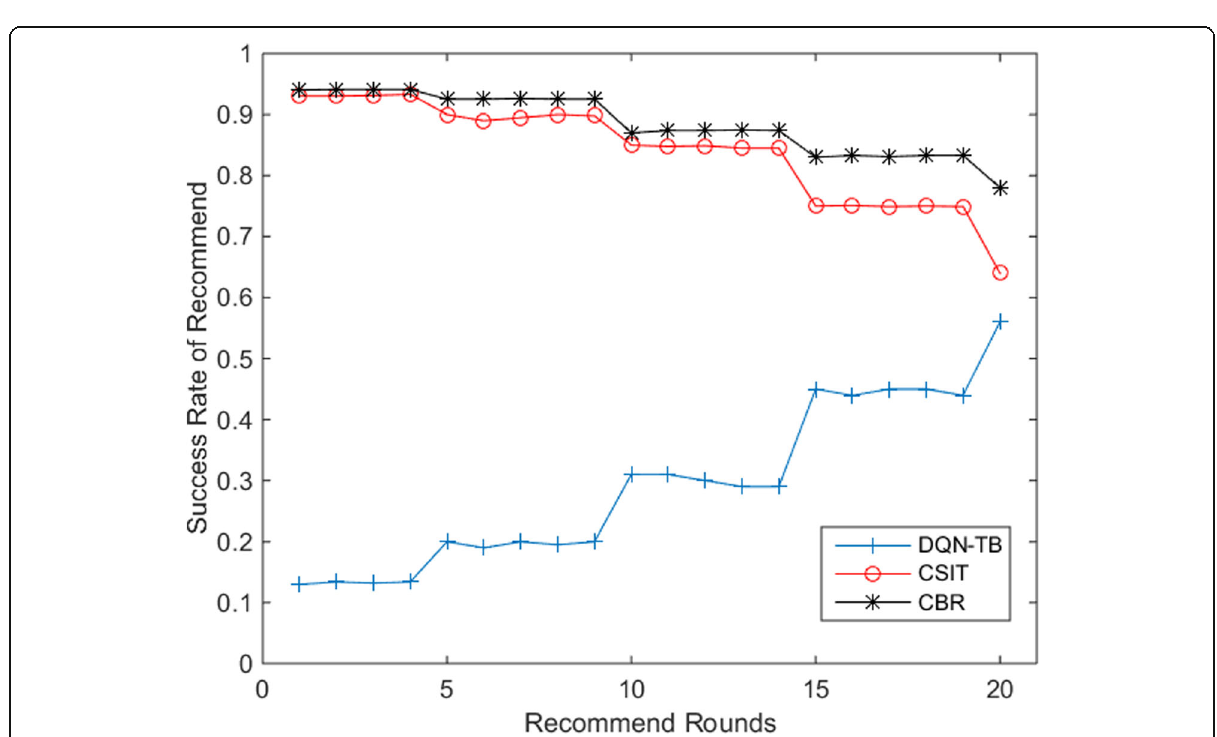
Fig. 13 Change of success rate with dynamic change a few